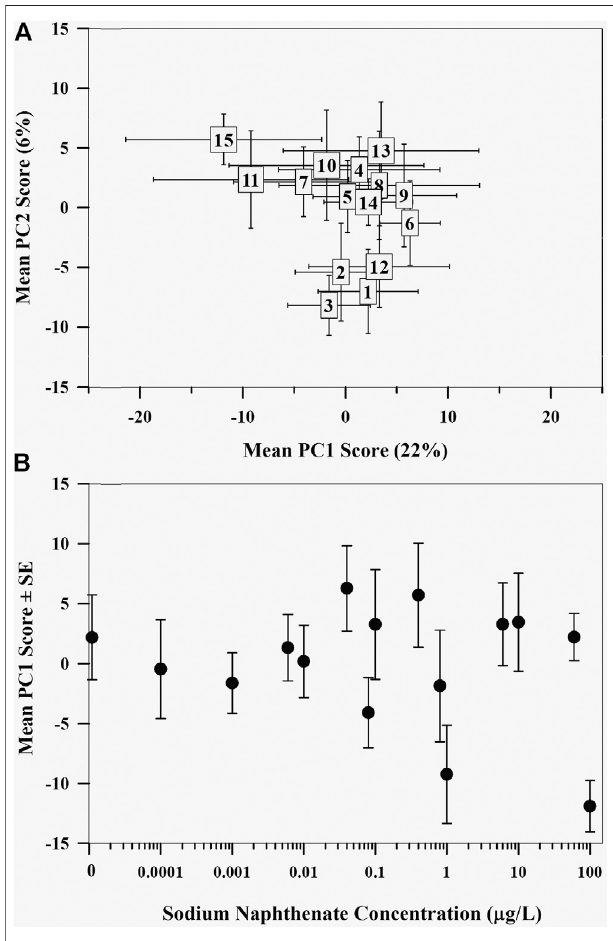
FIGURE 3 | (A) Mean principal component scores of the lipid metabolome of may fl ies ( Hexagenia spp.) exposed to sodium naphthenate. Numbers represent exposure from lowest 0 μ g L − 1 (1) to highest 100 μ g L − 1 (15) sodium naphthenate concentrations. Error bars indicate ± one standard error of the mean. (B) Mean fi rst principal component scores of the may fl y ( Hexagenia spp.) nymph lipid metabolome exposed to sodium naphthenate concentrations (0, 0.0001, 0.001, 0.006, 0.01, 0.04, 0.08, 0.1, 0.4,0.8,1,6,10,60,and100 μ g L − 1 ).Errorbarsindicate ± onestandarderror of the mean. Note the logarithmic scale in concentration along the x